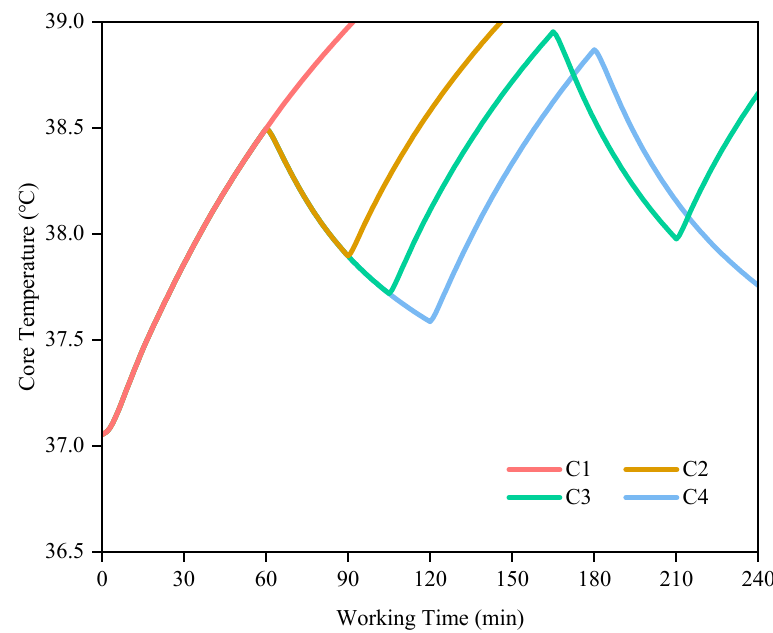
Figure 8. The predicted core temperature of grid workers in 240 min under different work/rest strategies (C1: a 240-min work; C2: a 30-min rest after a 60-min work; C3: a 45-min rest after a 60-min; C4: a 60-min rest after a 60-min work).